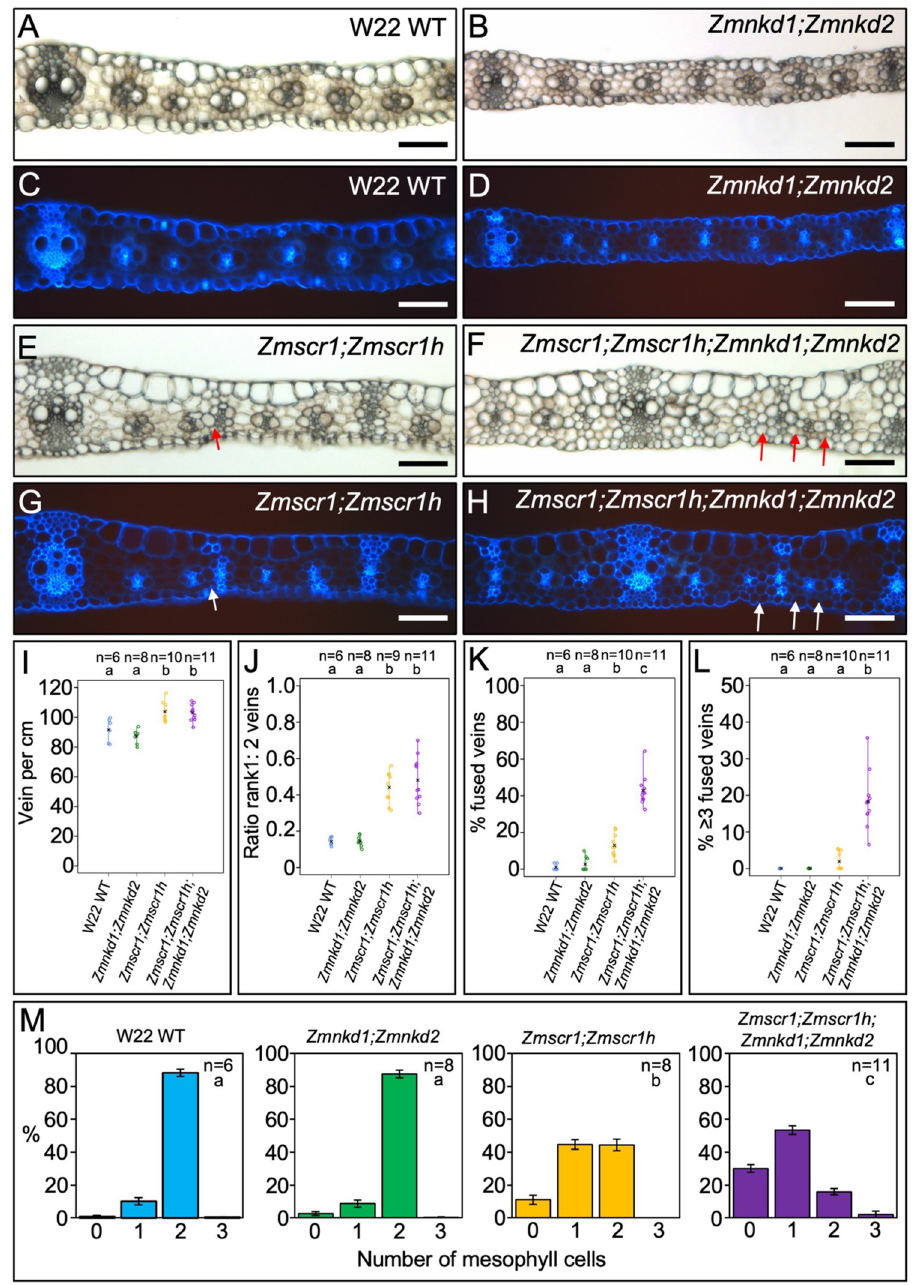
Fig 7. Zmscr1;Zmscr1h;Zmnkd1;Zmnkd2 quadruple mutants have a striking increase in the number of fused leaf veins compared to Zmscr1;Zmscr1h double mutants. A-H) Transverse cross sections of wild-type (WT) W22 (A & C), Zmnkd1-Ds;Zmnkd2-Ds (B & D), Zmscr1-m2;Zmscr1h-m1 (E & G) and Zmscr1-m2;Zmscr1h-m1;Zmnkd1-Ds; Zmnkd2-Ds (F & H) leaf 3, from the mid-point along the proximal distal axis and imaged under either brightfield (A-B, E-F) or UV (C-D, G-H) illumination. Quadruple mutants were segregating in progeny of selfed Zmscr1-m2; Zmscr1h-m1/+;Zmnkd1-Ds;Zmnkd2-Ds parents, nkd double mutants were derived from selfed Zmnkd1-Ds; Zmnkd2-Ds parents and scr double mutants from selfed Zmscr1-m2/+;Zmscr1h- m1 parents. Arrows point to fused veins. Scale bars: 100 μ m. I-L) Strip charts summarizing quantification of vein density (I), the ratio of rank 1: rank 2 intermediate veins (J), the % of fused veins (K) and the % of veins formed in runs of � 3 fused veins (L). Open circles indicate measurements from independent biological replicates, and black crosses indicate the mean for each genotype. The number of biological replicates (n =) is indicated above each plot and letters at the top of each plot indicate statistically different groups ( P � 0.05, one-way ANOVA and Tukey’s HSD) (raw data in S1 Table). M) Histograms